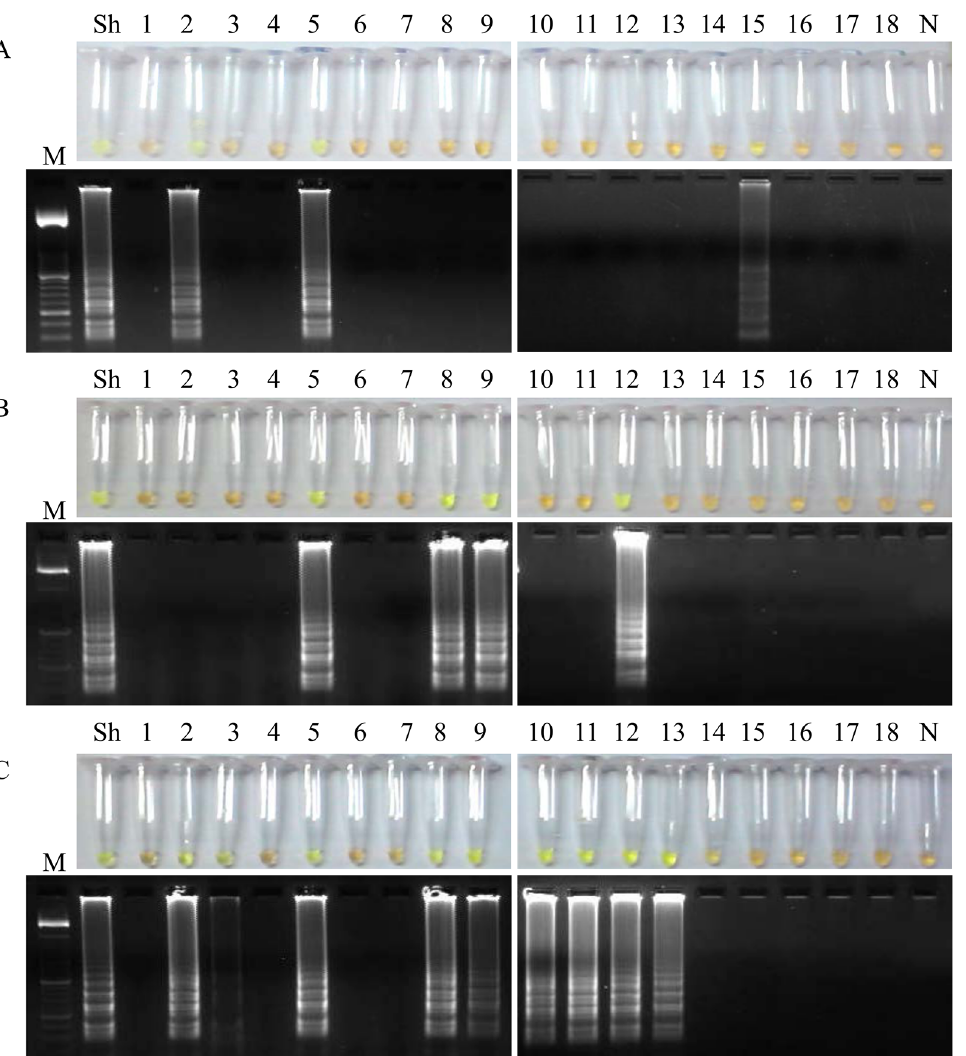
Fig 6. Examination of aliquots of supernatants from S . haematobium -positive patients´ urine samples by LAMP. Figure shows the LAMP results (up, by color change; down, by agarose electrophoresis) when using aliquots of 100 μ L of supernatants to obtain DNA as template by using (A) the i-genomic Urine DNA Extraction Mini Kit (Intron Biotechnology, UK); (B) the heating NaOH-SDS method and (C) the rapid heating method. Lanes M: 50 bp DNA ladder (Molecular weight marker XIII, Roche); lanes Sh: genomic DNA from S . haematobium (1 ng); lanes 1 – 18: S . haematobium -positive samples; lanes N: negative controls (no DNA